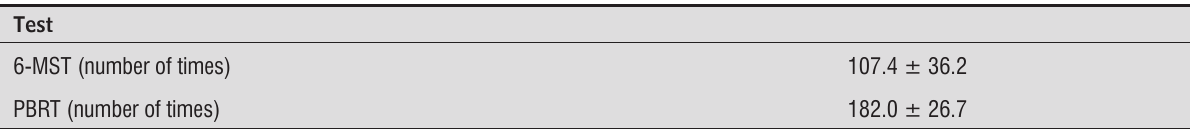
Table 2 - Functional capacity tests of the COPD group (n = 8)